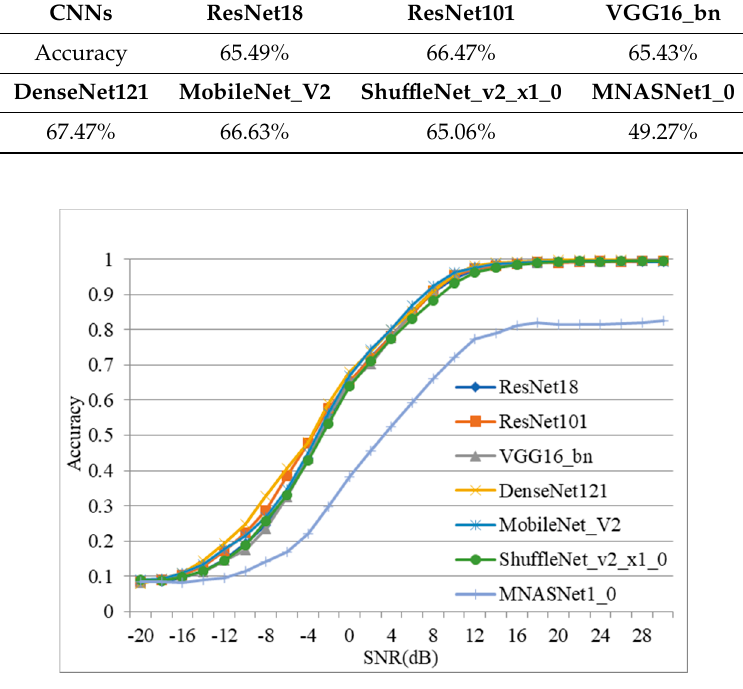
Figure 6. Comparison of the performance of different ImageNet classification network models. The convolution mapping method was adopted. Table 4. Comparison of the overall classification accuracy of different models. The convolution mapping method was adopted.